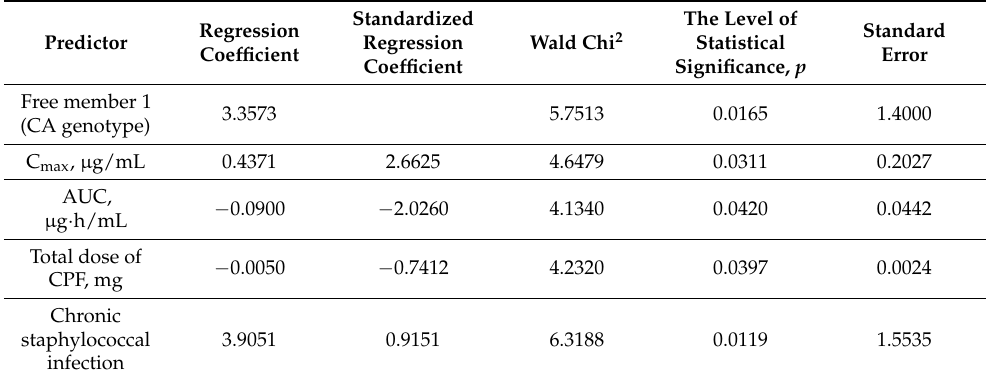
Table 7. Evaluation of logistic regression parameters with the dependent variable “CYP2C9*3 gene polymorphism I359L (c.1075A > C)”.